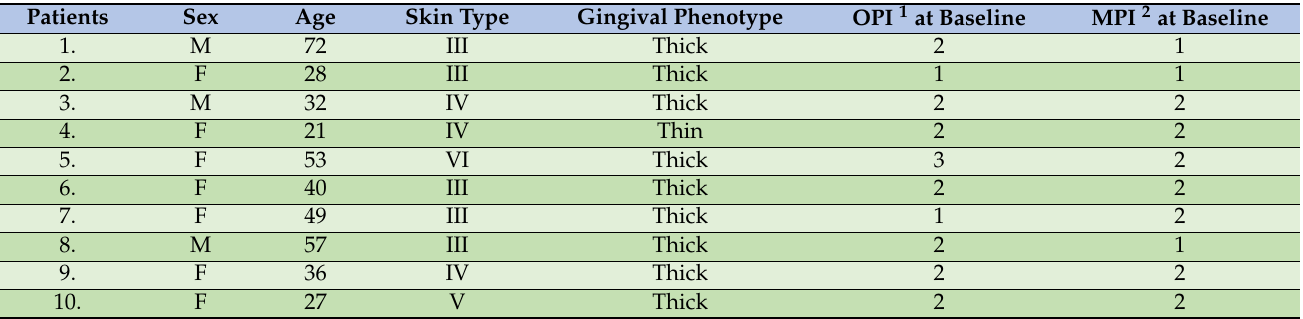
Table 2. Summary of patients’ demographics and clinical characteristics.